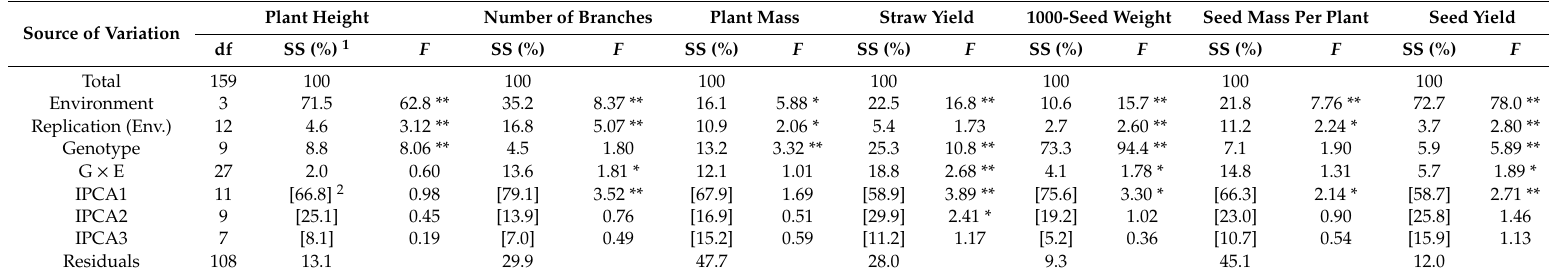
Table 3. The additive main e ff ects and multiplicative interaction (AMMI) analysis of variance in the traits of 10 camelina genotypes across four growing seasons (environments).